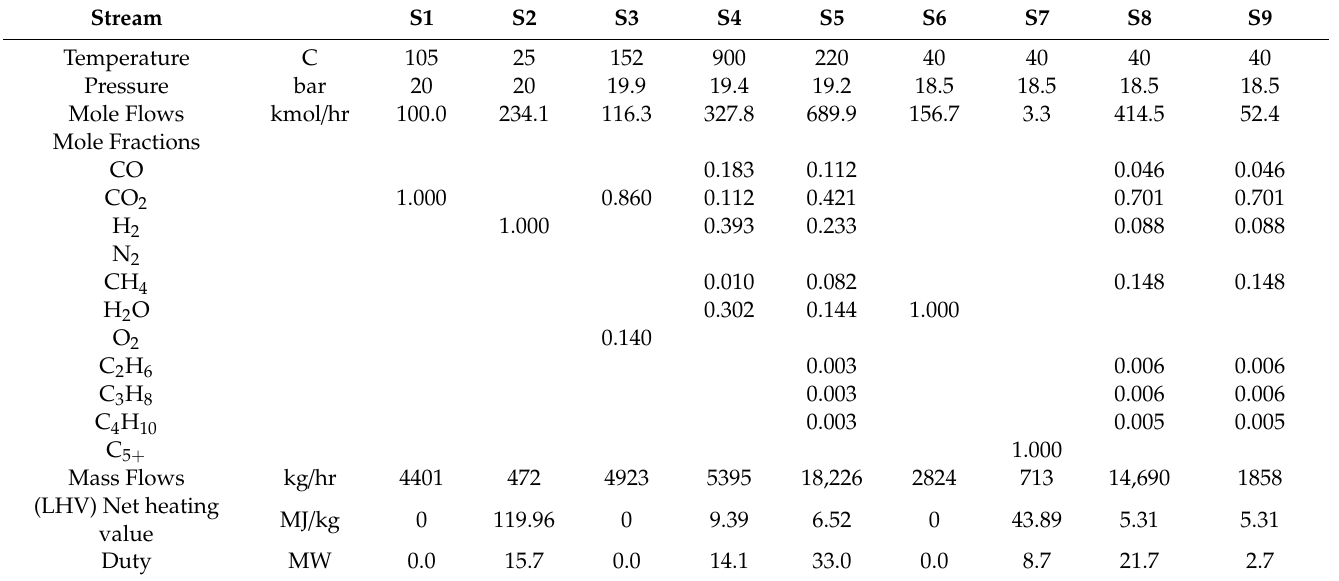
Table A2. Simulated stream results for